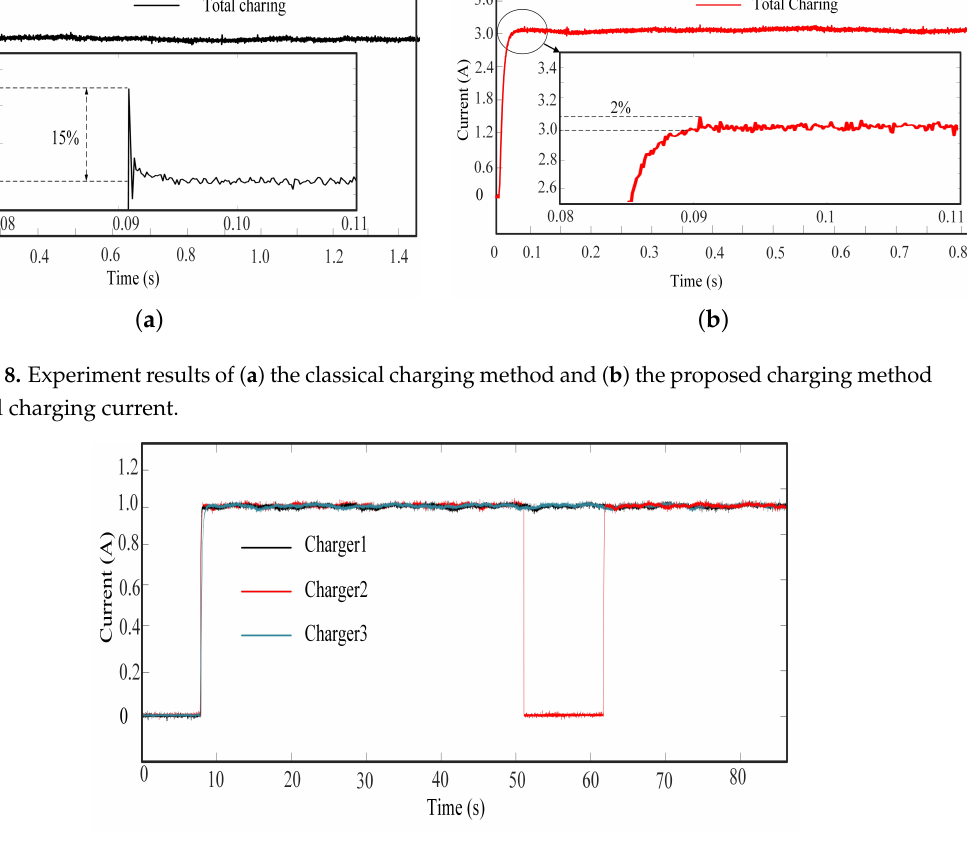
Figure 9. Charge current when charger fails.